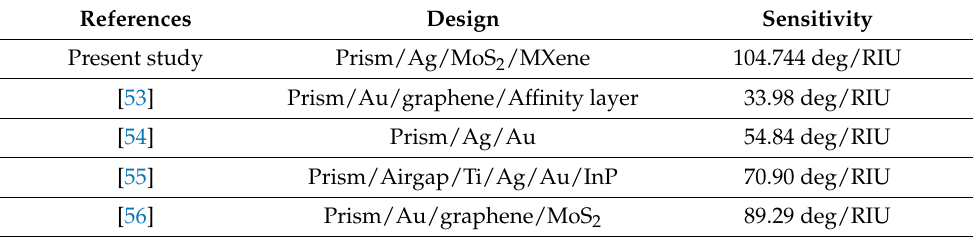
Table 6. Performance comparison for current work with existing SPR